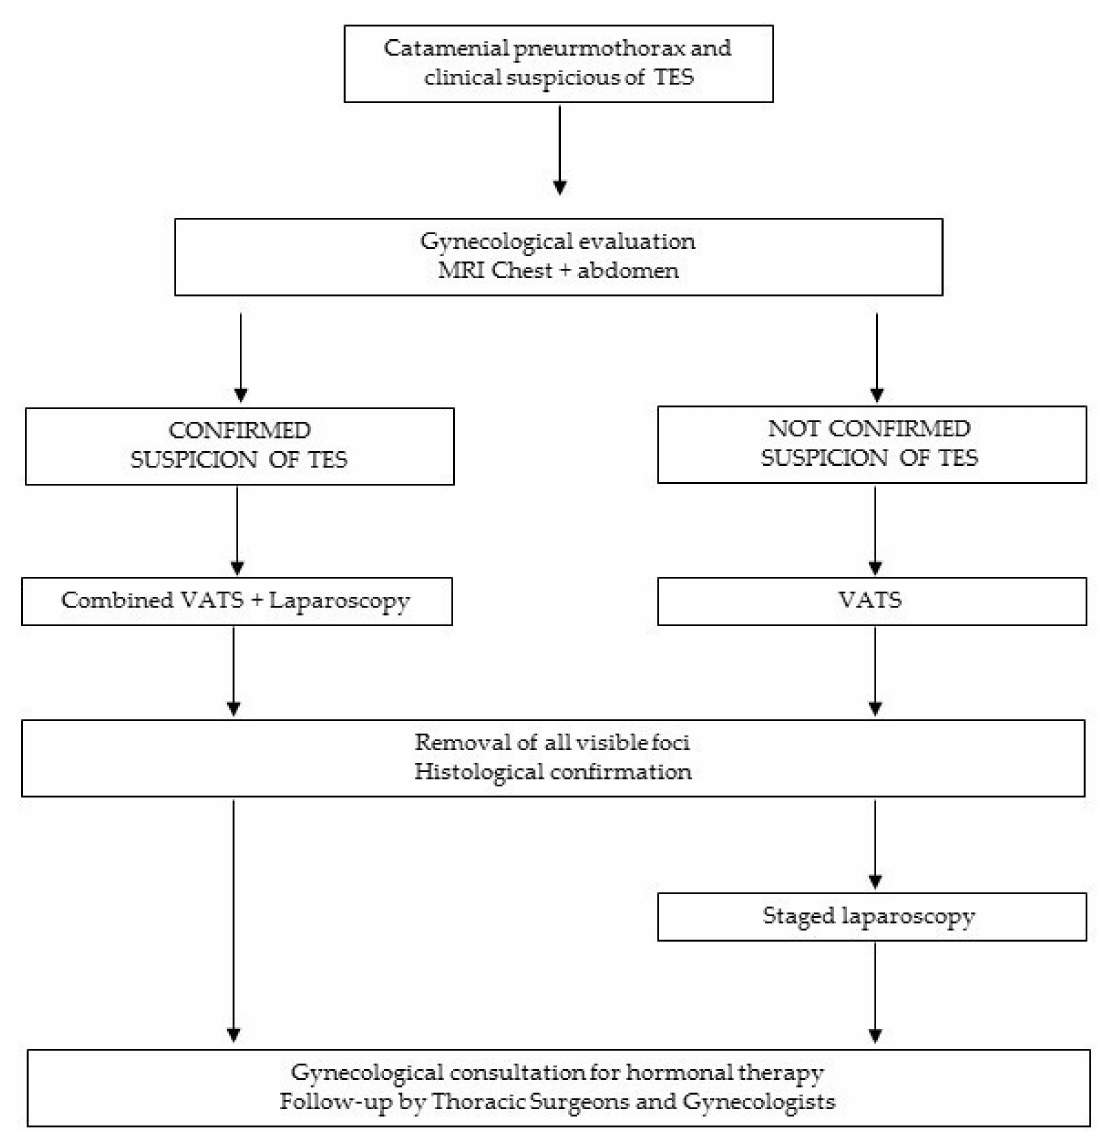
Figure 2. Flow chart for the multidisciplinary